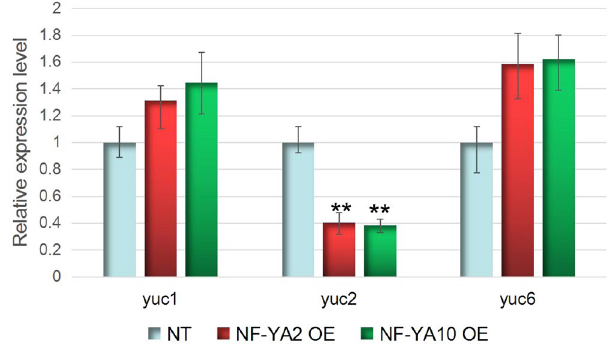
Figure 6. Yuc1, yuc2 and yuc6 expression in NT, NF-YA2 OE and NF-YA10 OE lines.